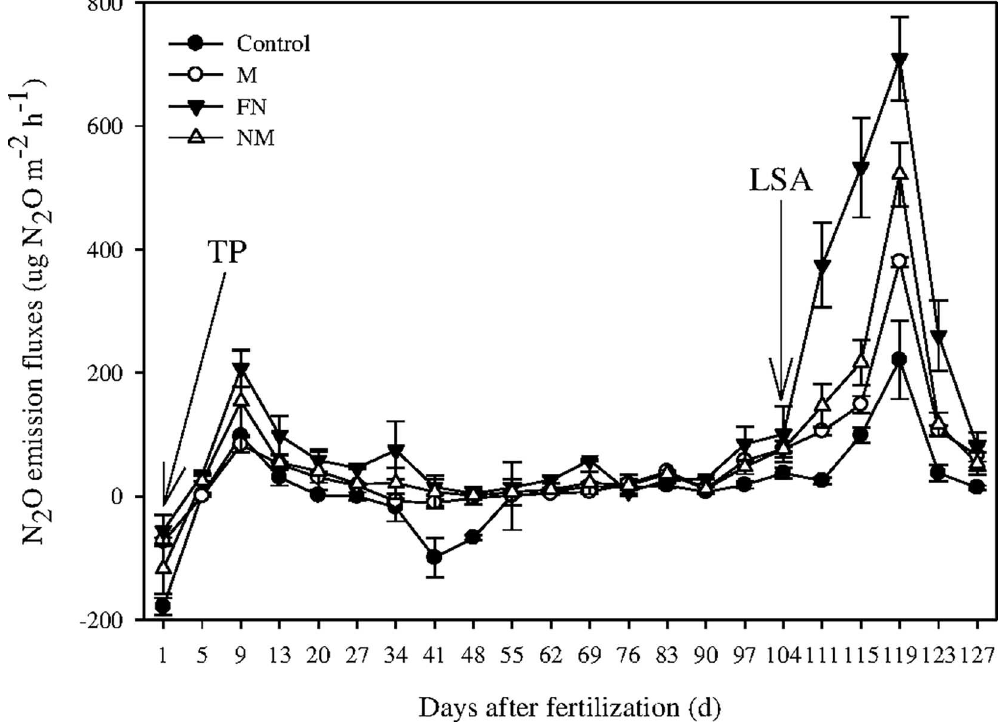
Fig 2. The N 2 O emission fluxes during the growing period of rice plants. TP was the time of transplanting rice seedlings, and LSA was the time of 20 days before rice harvest. Bars indicate standarderror (n = 3).